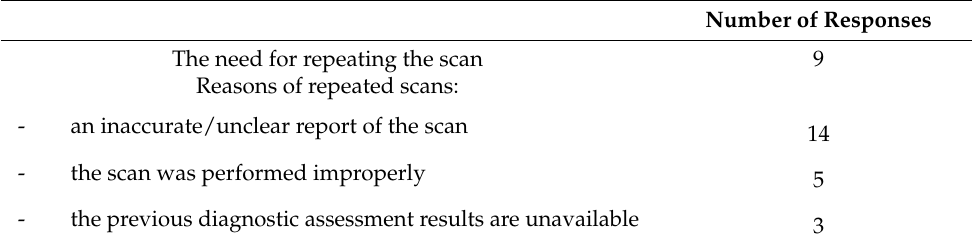
Table 3. The causes of necessary repetitions of magnetic resonance imaging scans.